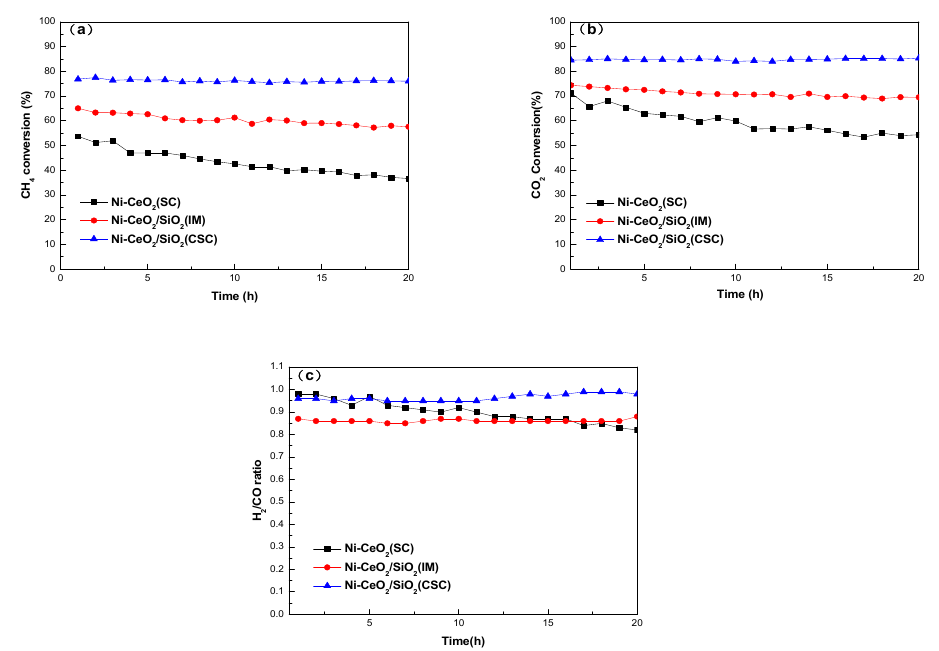
Figure 7. Catalyst tests of the Ni-CeO 2 (SC), Ni-CeO 2 / SiO 2 (IM), and Ni-CeO 2 / SiO 2 (CSC) catalysts at 700 ◦ C. ( a ) CH 4 conversions, ( b ) CO 2 conversions and (c) H 2 / CO ratio.